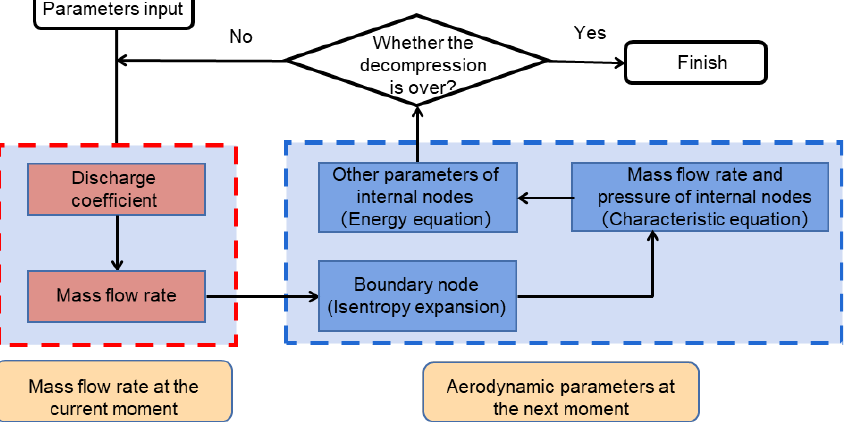
Figure 5. Calculation process of the 1-D model.